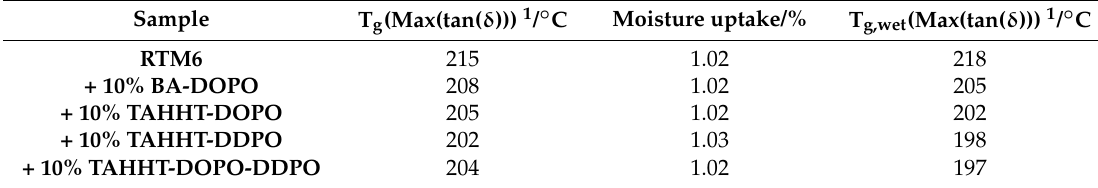
Table 3. Glass transition temperatures and moisture uptake of RTM6 samples.